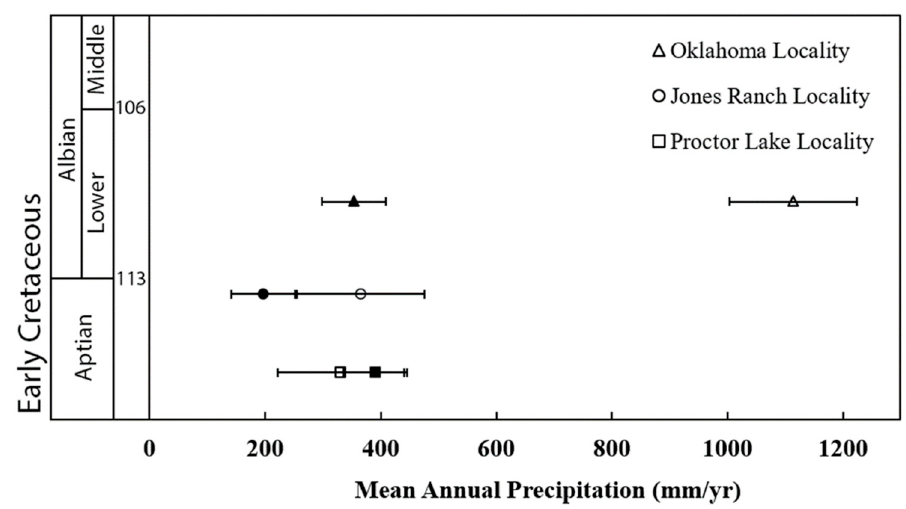
Figure 4. The average mean annual precipitation estimates for Lower Cretaceous localities in Texas and Oklahoma using ∆ 13 C cc-om , as outlined in Tabor et al. [42] (filled symbols, error bars ± 55 mm) and the CALMAG weathering index, as reported in Andrzejewski and Tabor [16] (open symbols, error bars ± 110 mm). Table 2. The mean annual precipitation estimates of Lower Cretaceous localities in Texas and Ok- lahoma using Δ 13 C cc-om [42], which are newly presented here, and CALMAG weathering index [41] MAP estimates, as reported in Andrzejewski and Tabor [16]. Soil-respired p CO 2 was then estimated from the mean annual precipitation estimates using the equations derived by Cotton and Sheldon (Equation (3), [40]). C s1 calculated soil-respired p CO 2 using MAP derived from Δ 13 C cc-om . C s2 calcu- lated soil-respired p CO 2 using MAP derived from the CALMAG weathering index.